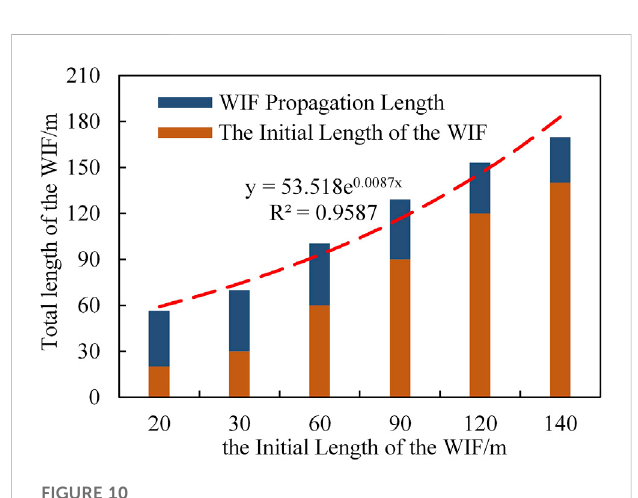
FIGURE 10 Effects of the initial length of the WIF on the WIF